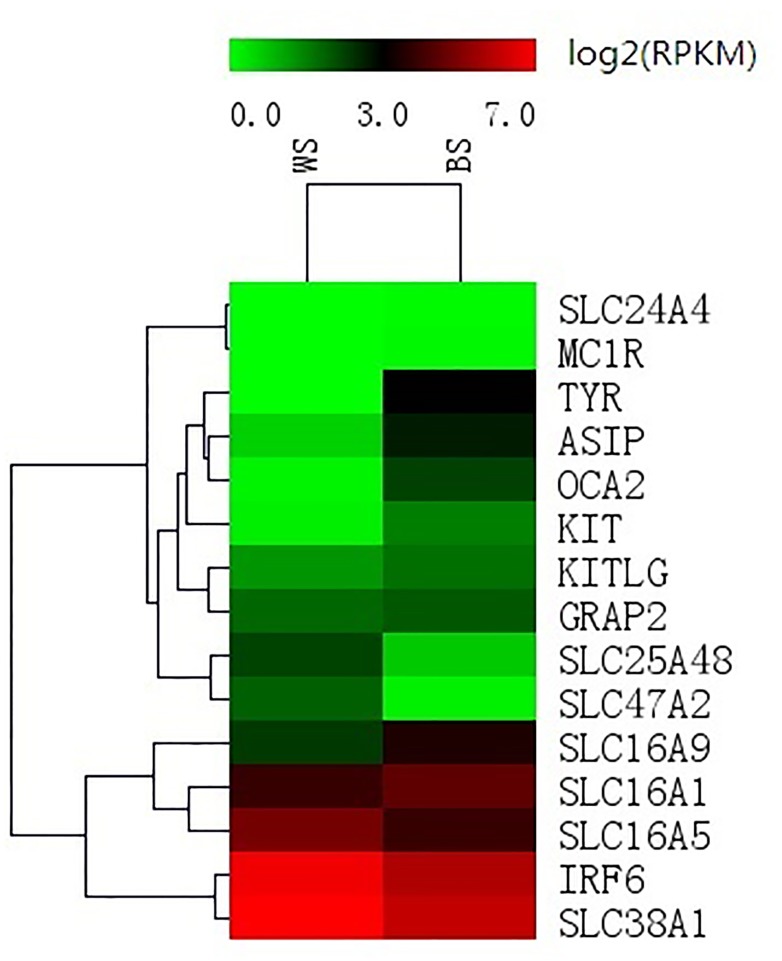
A heat-map exploring the differences in gene expression between WS and BS.Different colors represent different expression levels; a darker color represents higher expression and a greater log2 (RPKM) value.